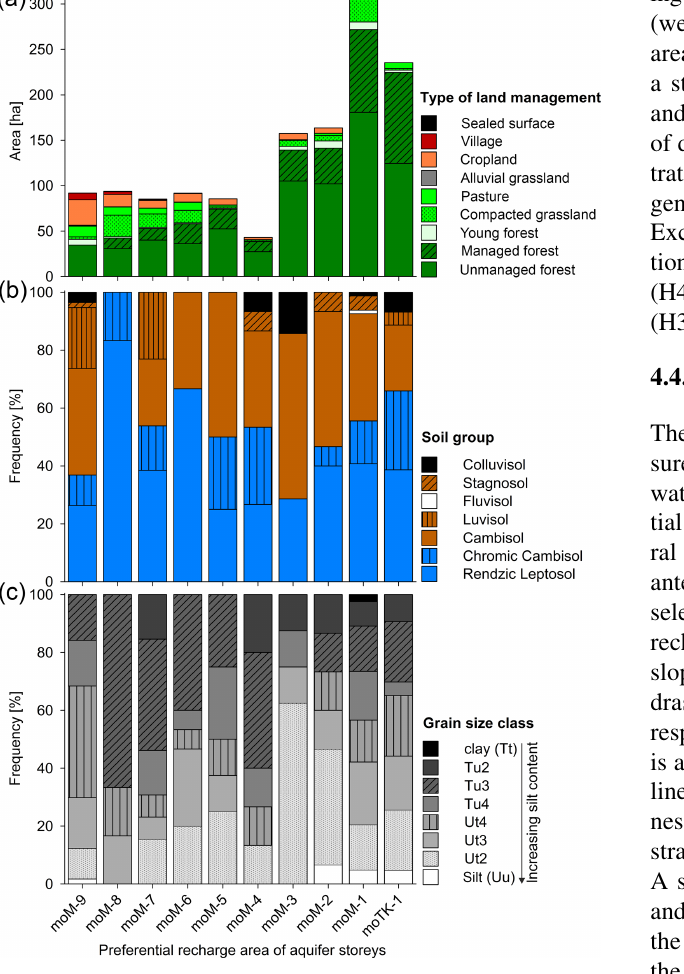
Figure 5. Surface and subsurface properties of the aquifer recharge zones (moTK-1 to moM-9) on the Hainich hillslope. Area sizes are related to the 29km 2 area of this study. (a) Absolute abundances of land management types in the preferential recharge areas of the aquifer storeys. The two basal aquifer storeys are characterized by the largest aquifer outcrop areas and the highest amounts of for- est within these areas. Agricultural land management increases to- wards the higher aquifer storeys (moM-2 to moM-9). (b) Relative abundances of soil groups within the aquifer outcrop zones showing high diversity in all aquifer outcrop zones depending on slope po- sitions and Quaternary loess loam/alluvial clay coverage. (c) Grain size classes of the topsoils and subsoils in the aquifer outcrop